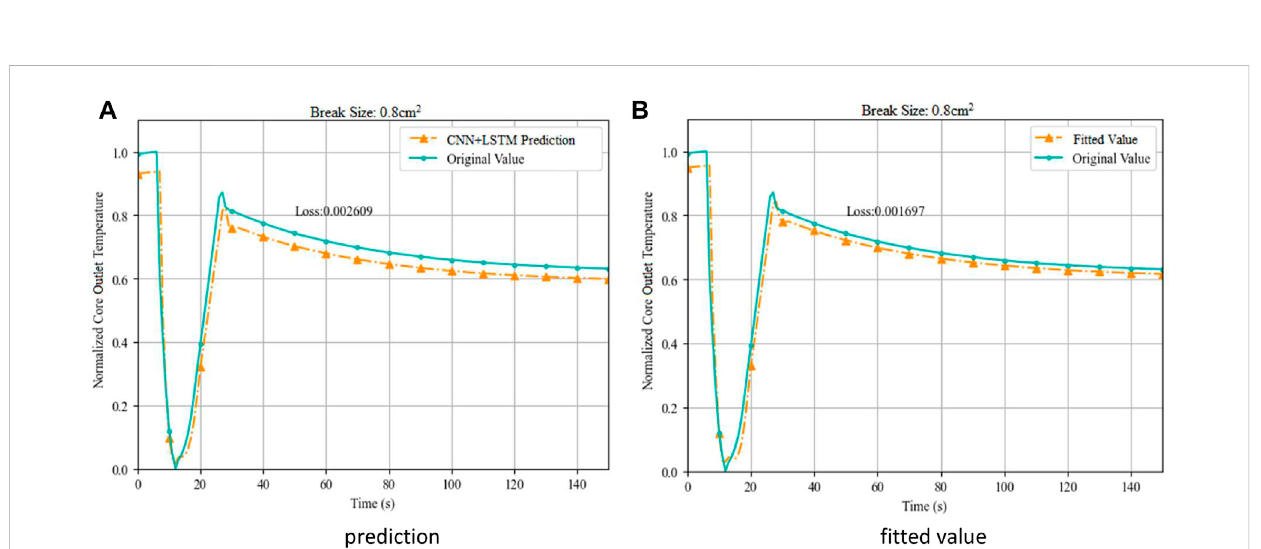
FIGURE 6 Prediction and Fitting of Core Outlet Temperature on Break Size 0.8 cm 2 . (A) prediction (B) fi tted value.